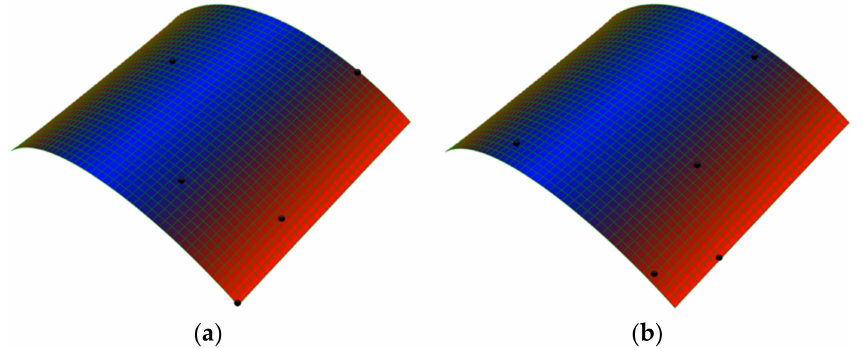
Figure 4. The random points chosen to apply load ( a ) and to extract the dynamic response of the bistable plate ( b ).